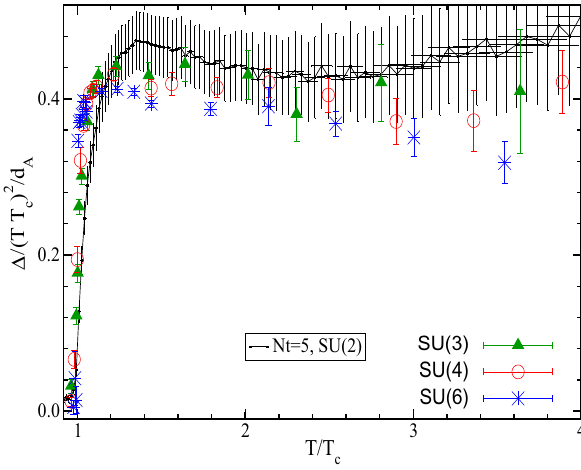
Fig. 22 Comparison of the trace anomaly in the deconfined phase with Ref.